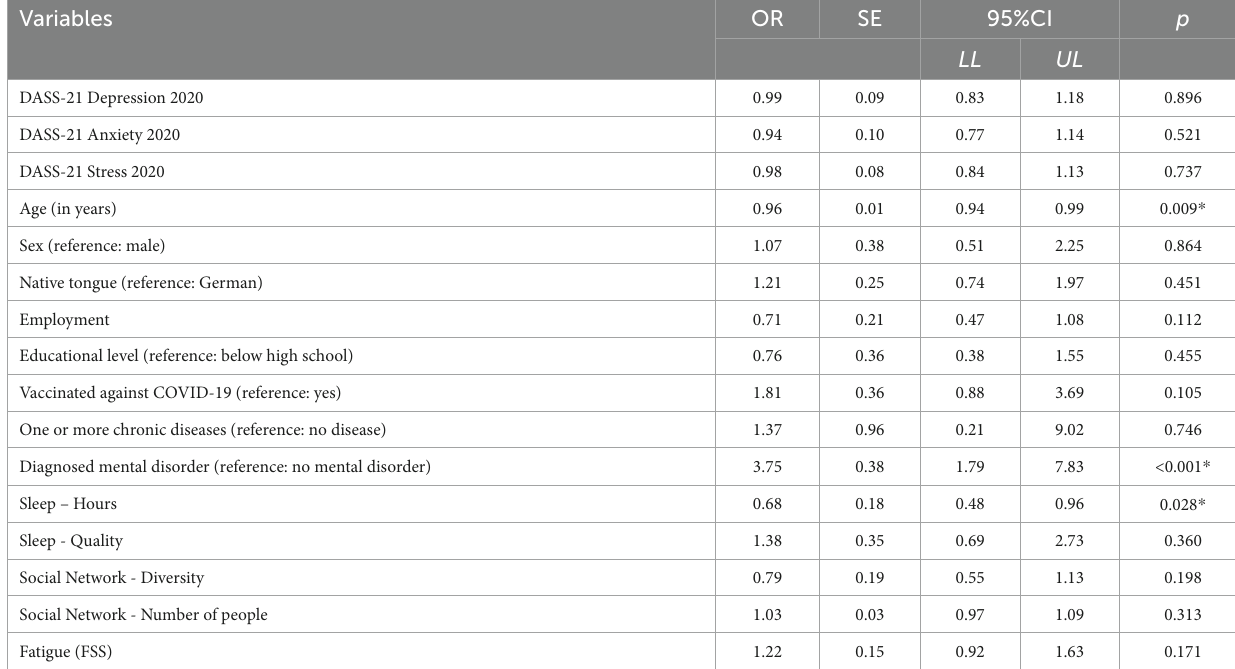
TABLE 8 Binary logistic regression analyses showing the association between depression, anxiety and stress (DASS-21) in 2020 and confirmed SARS- CoV-2-infection in 2021 ( n = 305).